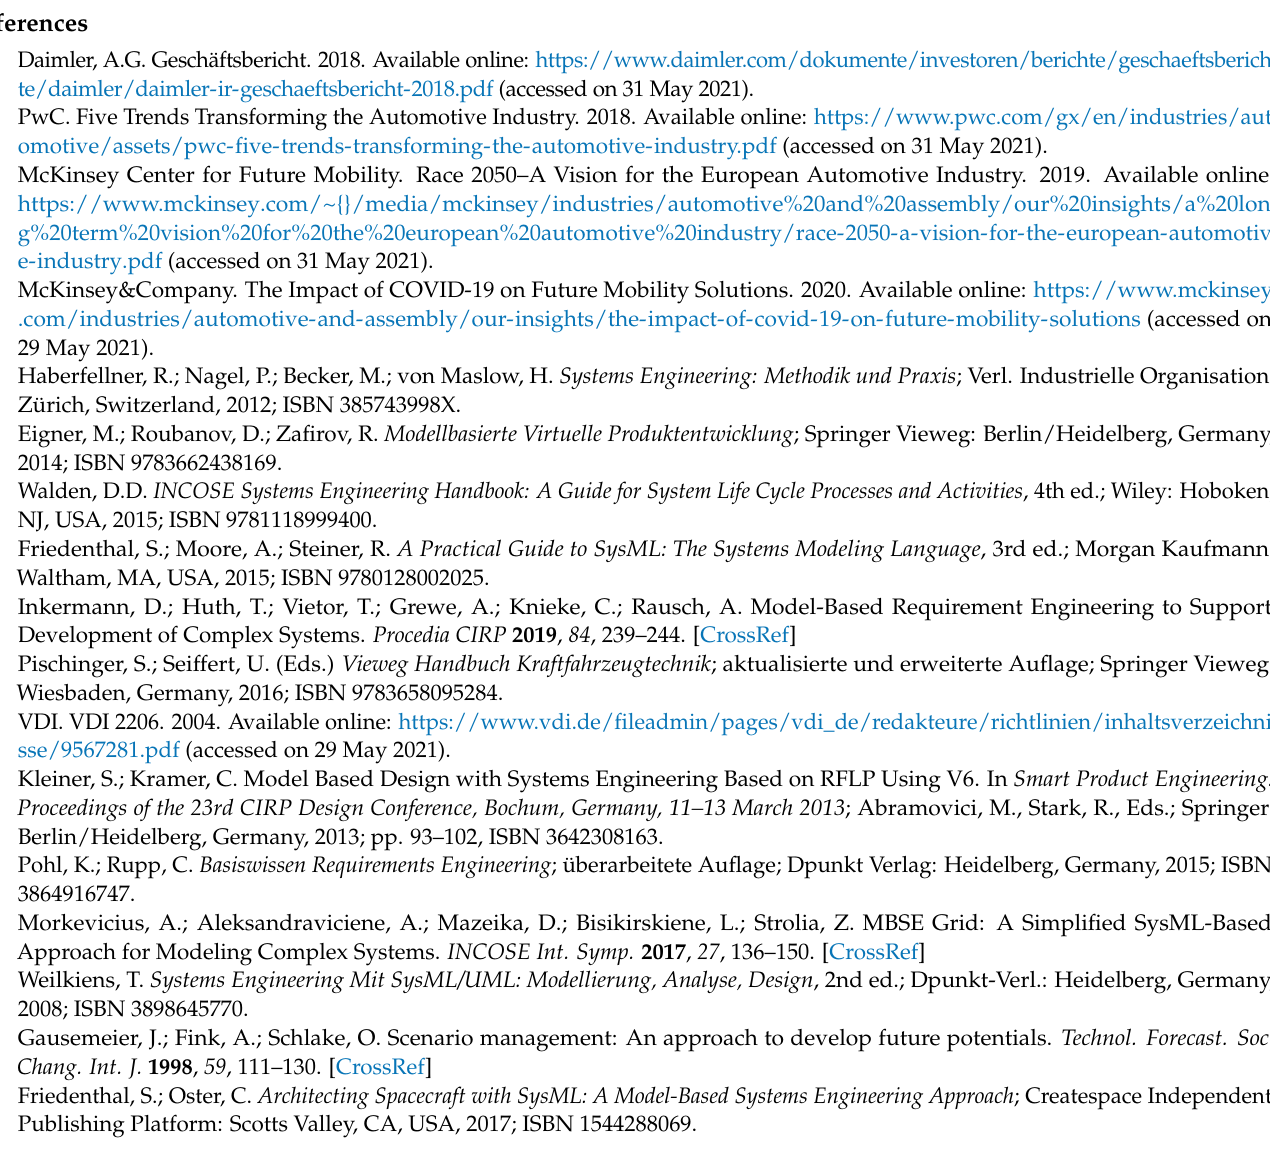
Figure A2. Connection of the sociological descriptors with the SOI requirements.